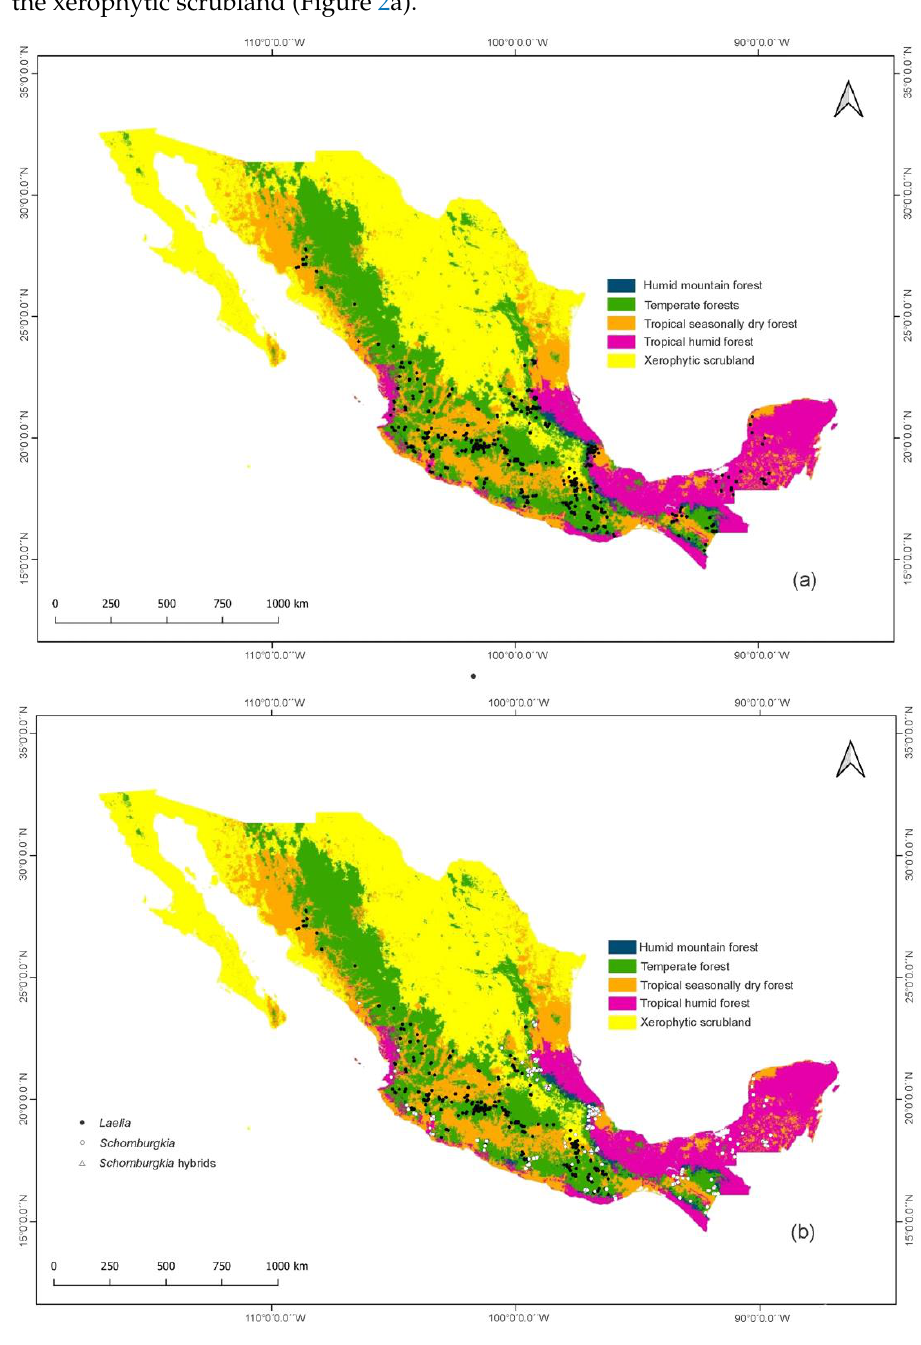
Figure 2. Distribution of ( a ) Laelia s.l., ( b ) Laelia s.s., and Schomburgkia in the five biomes of Mexico proposed by Villaseñor and Ortiz [39].